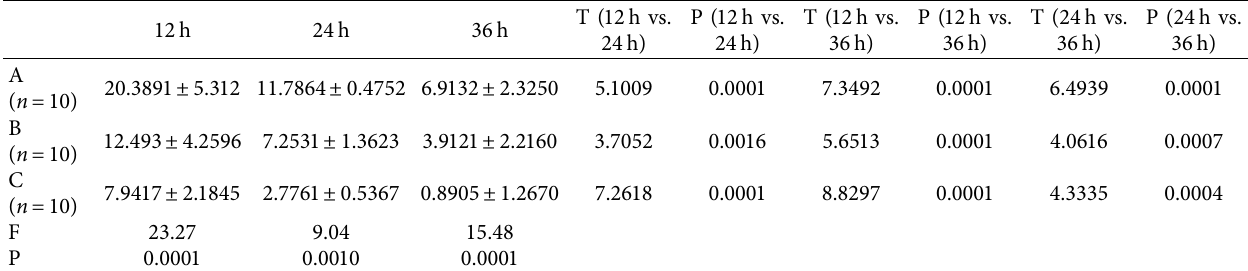
Table 2: Acetylcholine content in corneal epithelium of each group at 12h, 24 h, and 36h after corneal epithelium removal. 12h 24